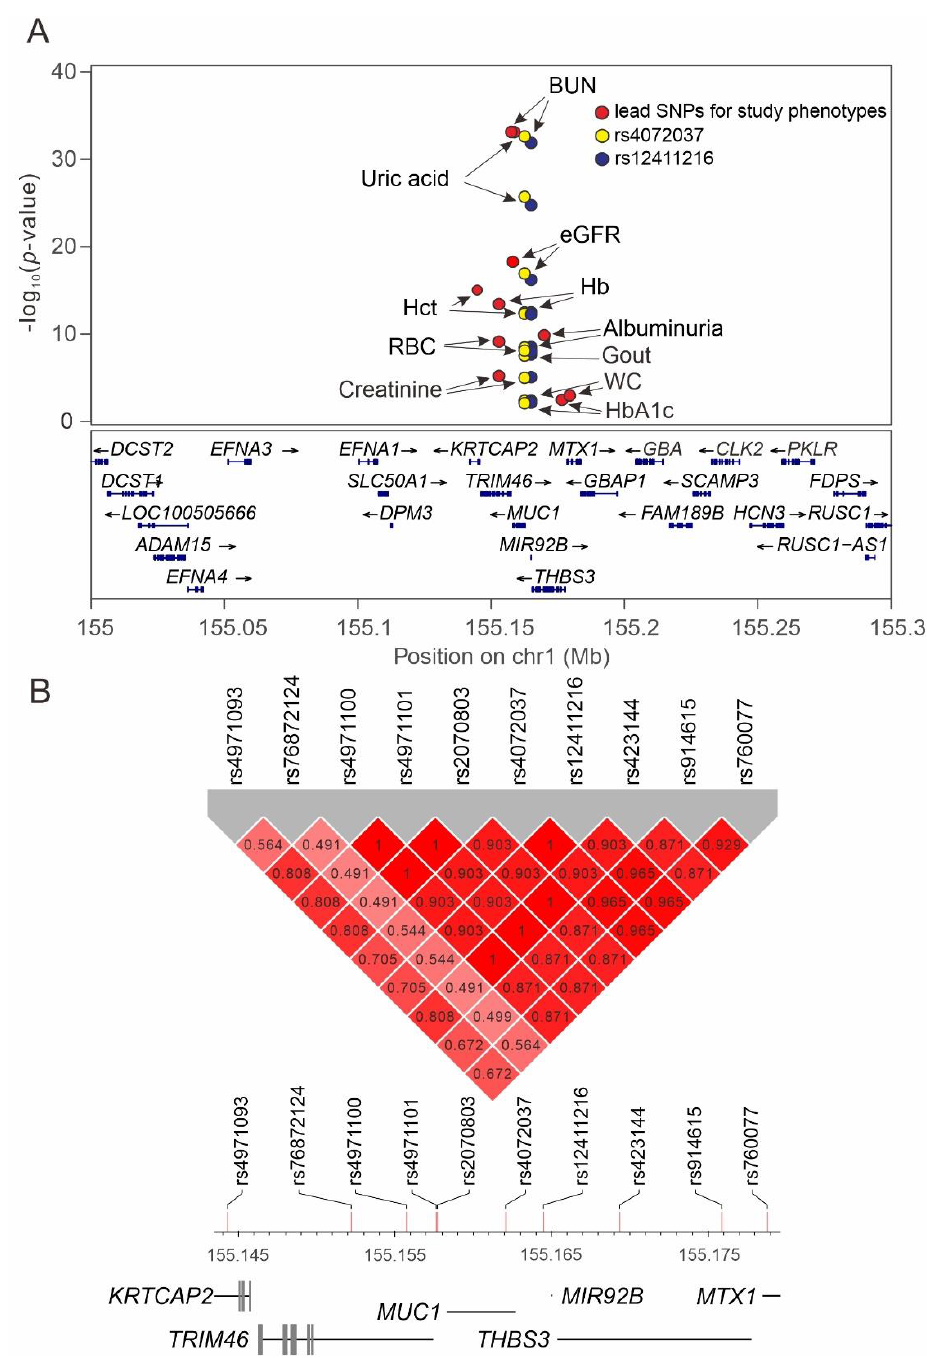
Figure 4. Combination of regional plot association studies between genetic variants at positions 155.0 to 155.3 mega-base (Mb) on chromosome 1q22 and multiple phenotypes. ( A ) For each phenotype, single-nucleotide polymorphism (SNP) rs12411216 is shown in purple, SNP rs4072037 is shown in yellow, and other lead SNPs are shown in red, except for gout in which the lead SNP was rs12411216. The lead SNP for each phenotype is indicated by an arrow. ( B ) Linkage disequilibrium maps for the MUC1 functional variants and lead SNPs in the TRIM46 – MUC1 – THBS3 – MTX1 gene region. BUN: blood urea nitrogen, eGFR: estimated glomerular filtration rate, Hb: hemoglobin, Hct: hematocrit, RBC: red blood cell, WC: waist circumference.